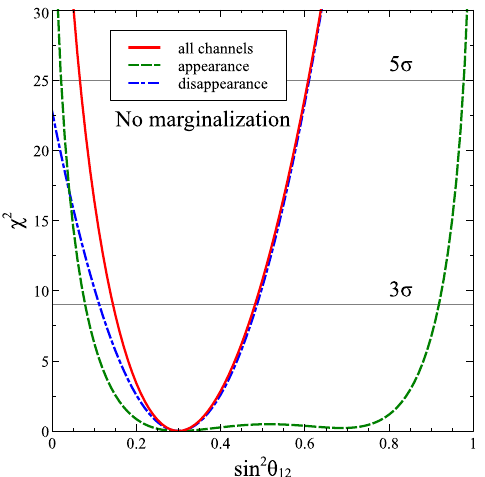
Figure 2 . χ 2 as a function of sin 2 θ 12 for T2HK mock data generated at sin 2 θ 12 = 0 . 31 corre- sponding to the LMA solution and fitted by varying sin 2 θ 12 while all other parameters are fixed. Results are shown for analysis of appearance channel data only, disappearance channel data only and for the combination of both appearance and disappearance channel data.